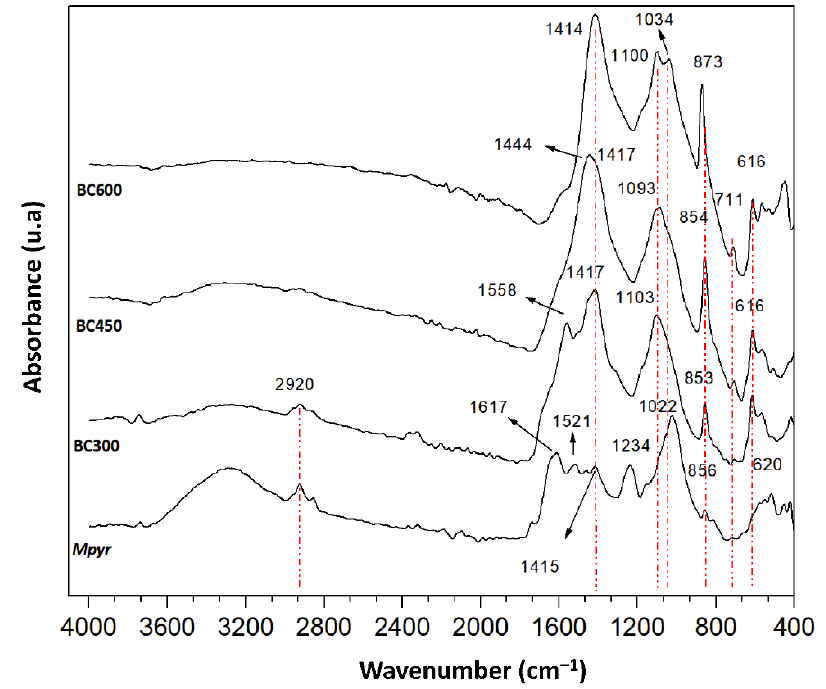
Figure 2. Fourier transform infrared (FTIR) spectrum of dry biomass of biochar samples from Macrocystis pyrifera ( Mpyr ) generated at 300 (BC300), 450 (BC450), and 600 °C (BC600) of the final pyrolysis temperature.